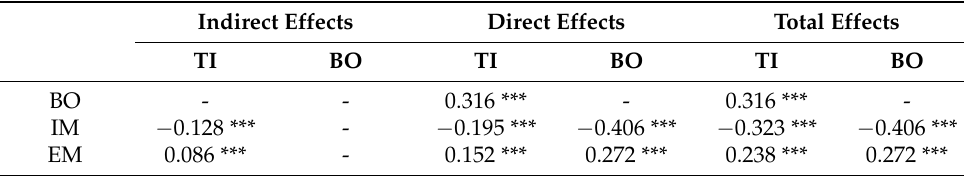
Table 6. Direct and indirect